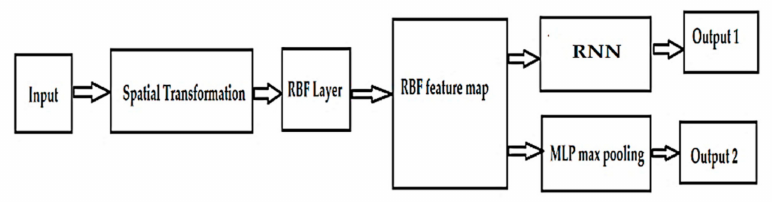
Figure 17. The architecture proposed for a modifed RBF